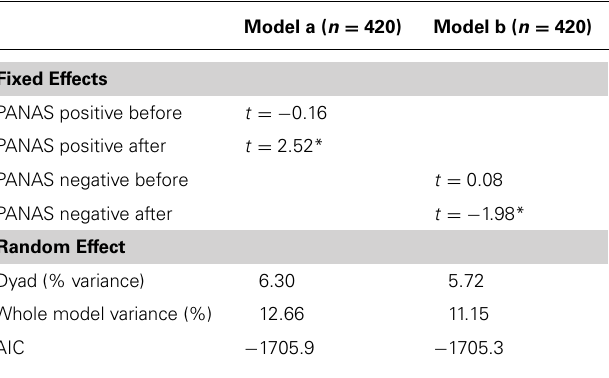
Table 4 | Mixed effects models of N = 84 dyads in five interaction conditions. Dependent variable, nonverbal